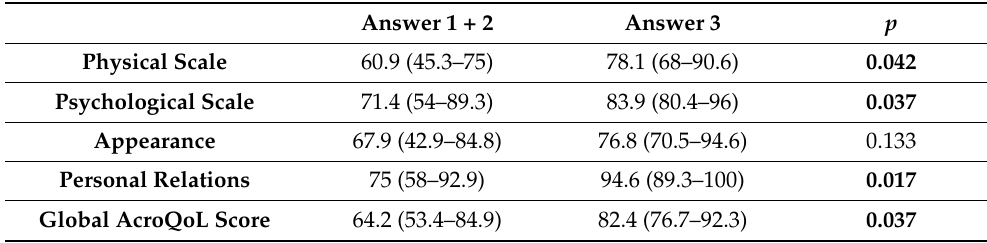
Table 4. The difference in AcroQoL results between different groups divided by general attitude towards preventative public health measures during the pandemic.